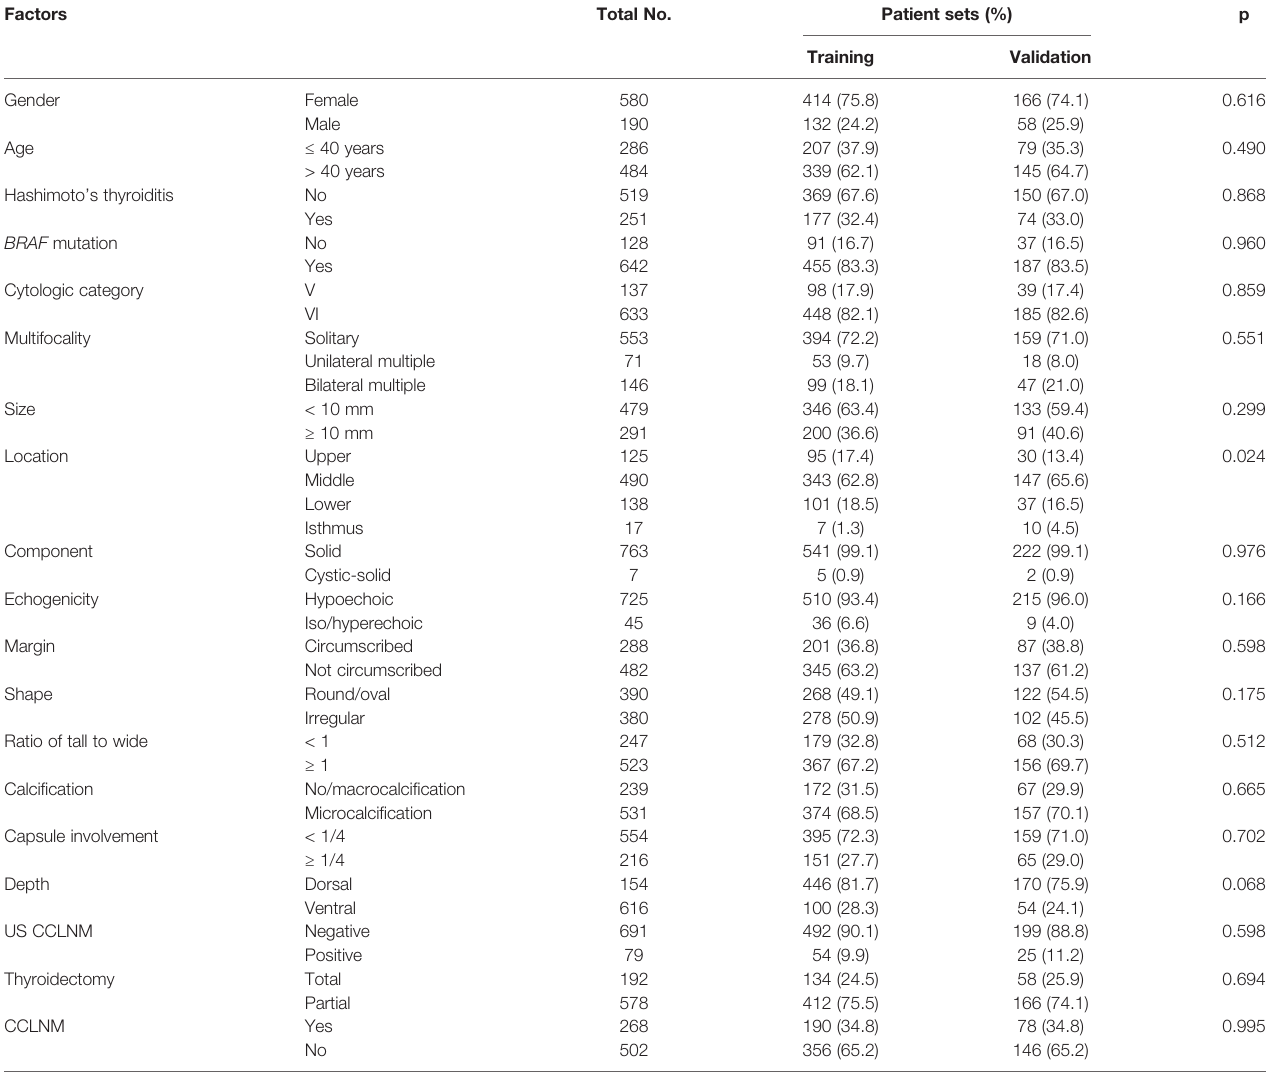
TABLE 1 | Patient